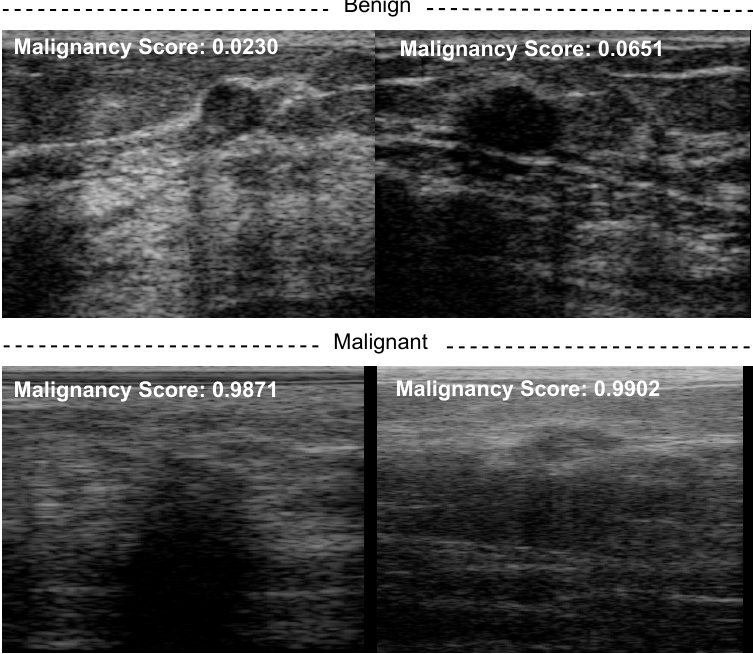
Figure 8. Examples of classification results using our method: ( top ) benign and ( bottom ) malignant breast